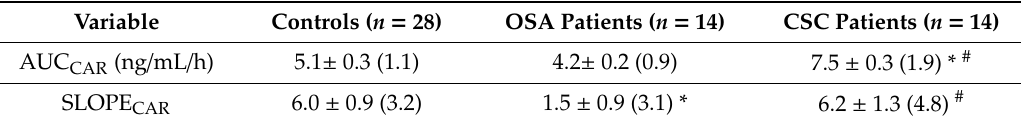
Table 3. Salivary cortisol AUC CAR and SLOPE CAR in OSA and CSC study